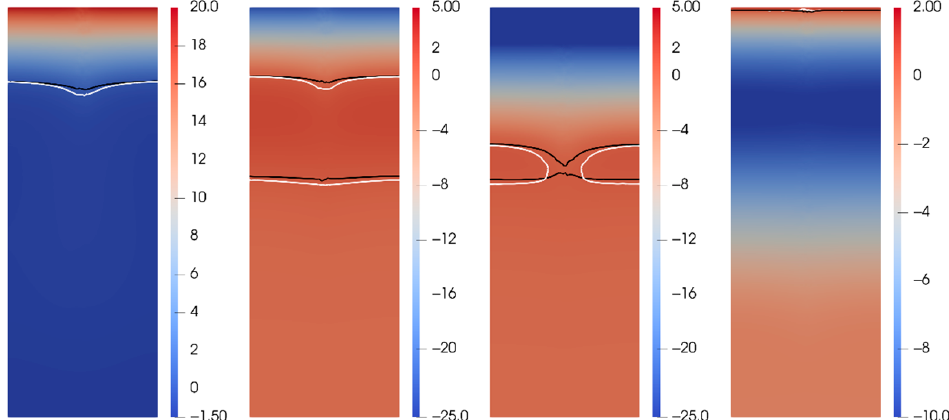
Figure 5. Temperature distribution for different time layers ( t = 50, 200, 250, 365 days) when the fibers are randomly located. From left to right. (white line is isocline of zero of steel, black is isocline of zero of basalt).